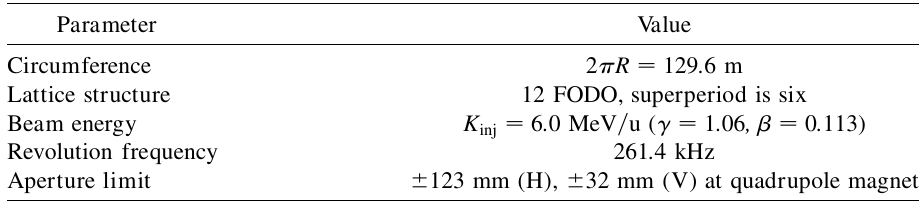
TABLE I. Parameters of the HIMAC synchrotron at injection energy.